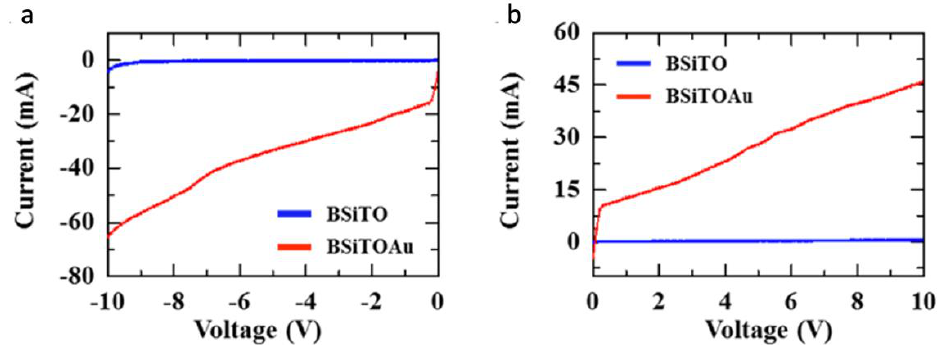
Figure 10. Photocurrents measured in both negative ( a ) and positive ( b ) voltage on BSi loaded with 40 nm of TiO 2 and 40 nm of Au. Adapted from [82] with permission from Elsevier, 2018